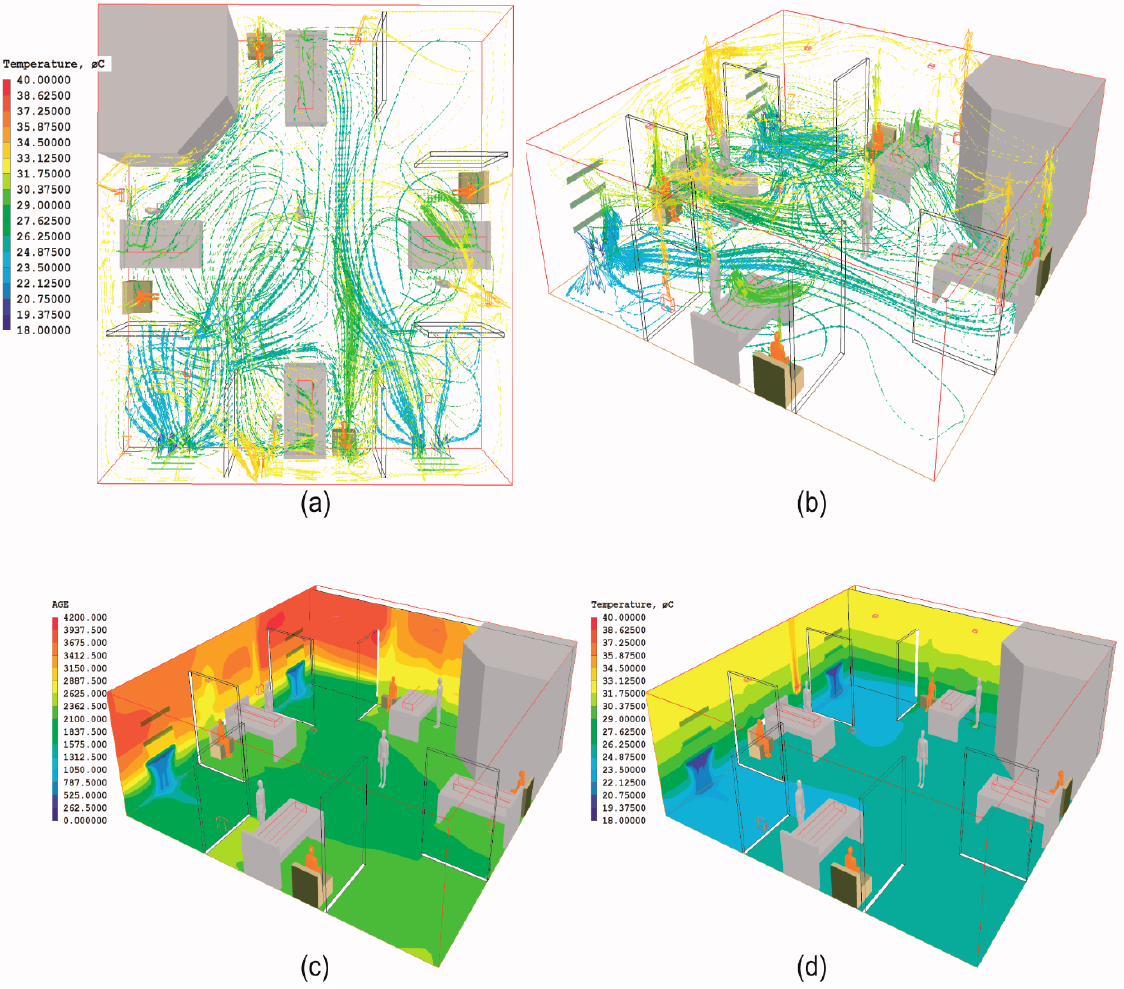
Figure 10. Airflow characteristics in Cruciform Ward showing pattern and direction of air movement in: ( a ) Top view; and ( b ) Isometric view; with contours for ( c ) Age of air; ( d ) Stratified